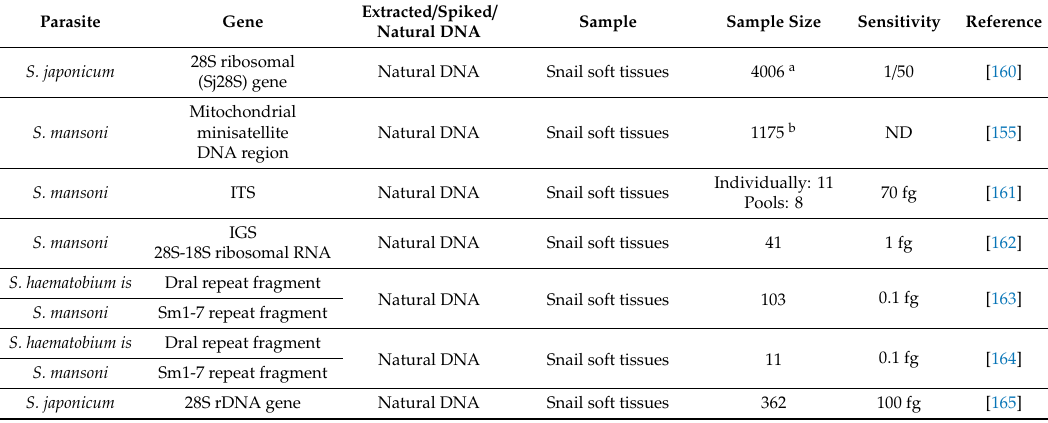
Table 16. Publications found in the US National Library of Medicine National Institutes of Health (NCBI-PubMed) reporting the standardisation of the LAMP technique as a useful tool for diagnosing schistosomiasis in the